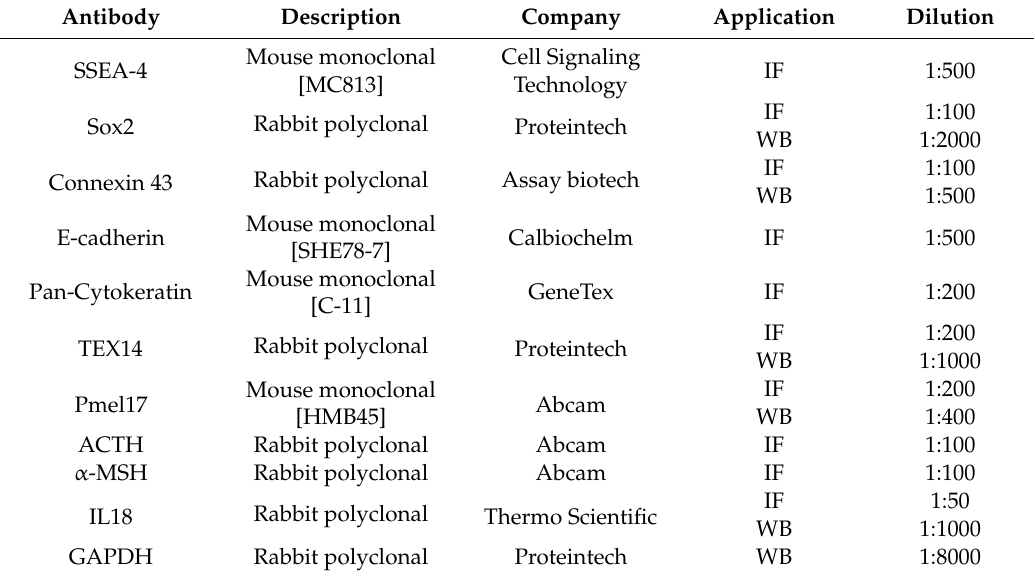
Table 1. List of primary antibodies used for immunocytochemical and immunoblotting studies. Stemness markers: SSEA-4, stage-specific embryonic antigen-4; Sox2, SRY (sex determining